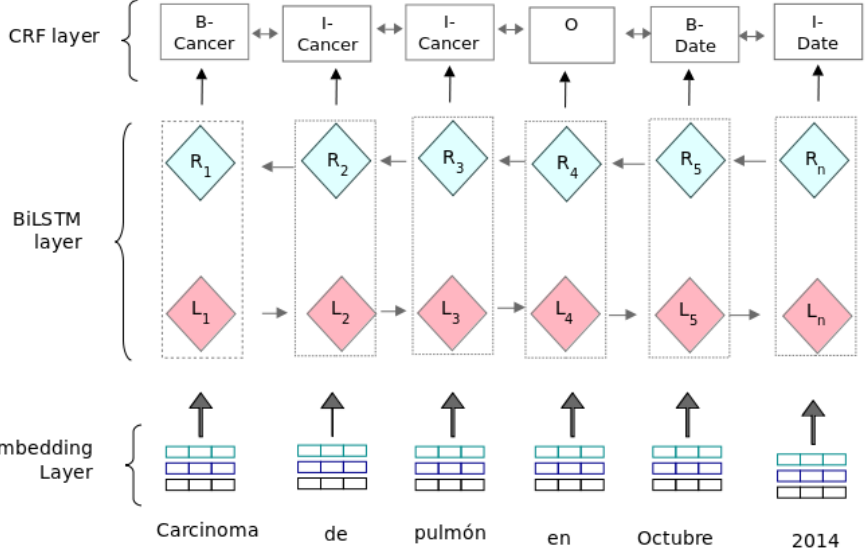
Figure 3. Bidirectional Long Short-Term Memory/Conditional Random Field (BiLSTM-CRF)